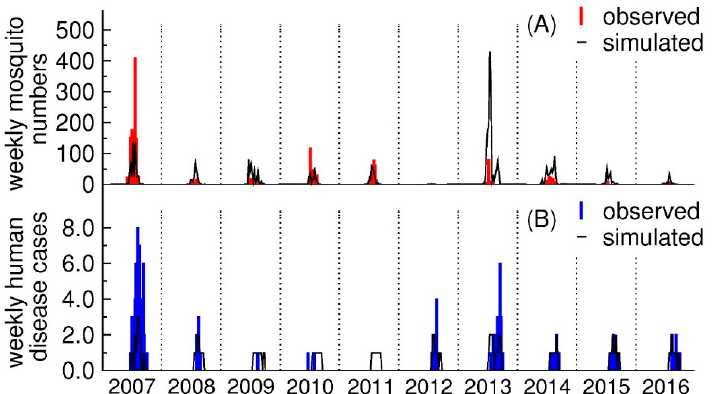
Figure 6. Comparisons between observed and simulated mosquito numbers and human disease cases. Panel ( A ) shows weekly numbers of female Culex tarsalis mosquitoes and Panel ( B ) shows the numbers of weekly human disease cases. The observed mosquito numbers are the averaged data from all traps.